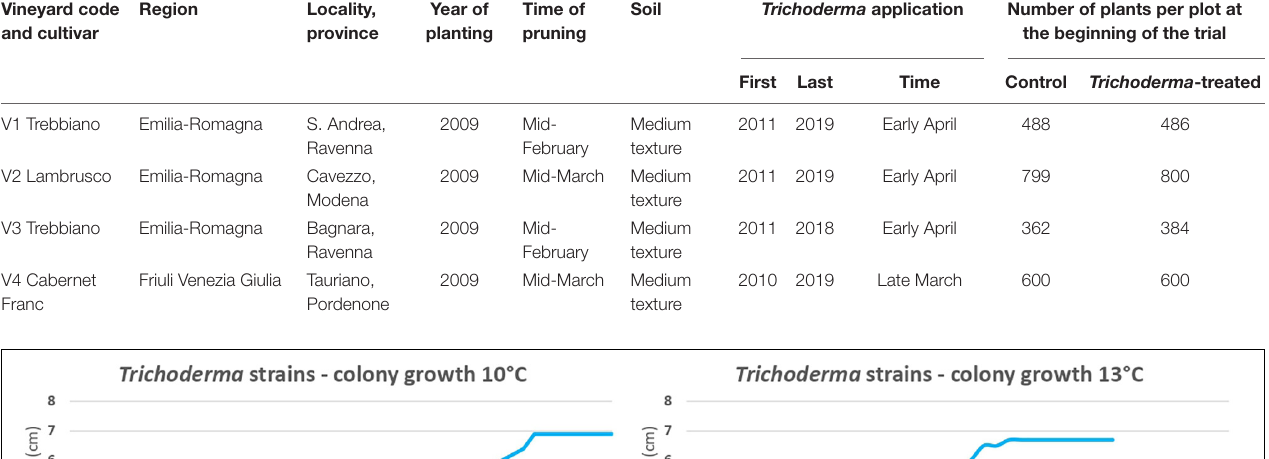
TABLE 1 | List of the vineyards where the on-field applications of the Trichoderm a formulations on pruning wounds were carried out. Vineyard code Region and cultivar